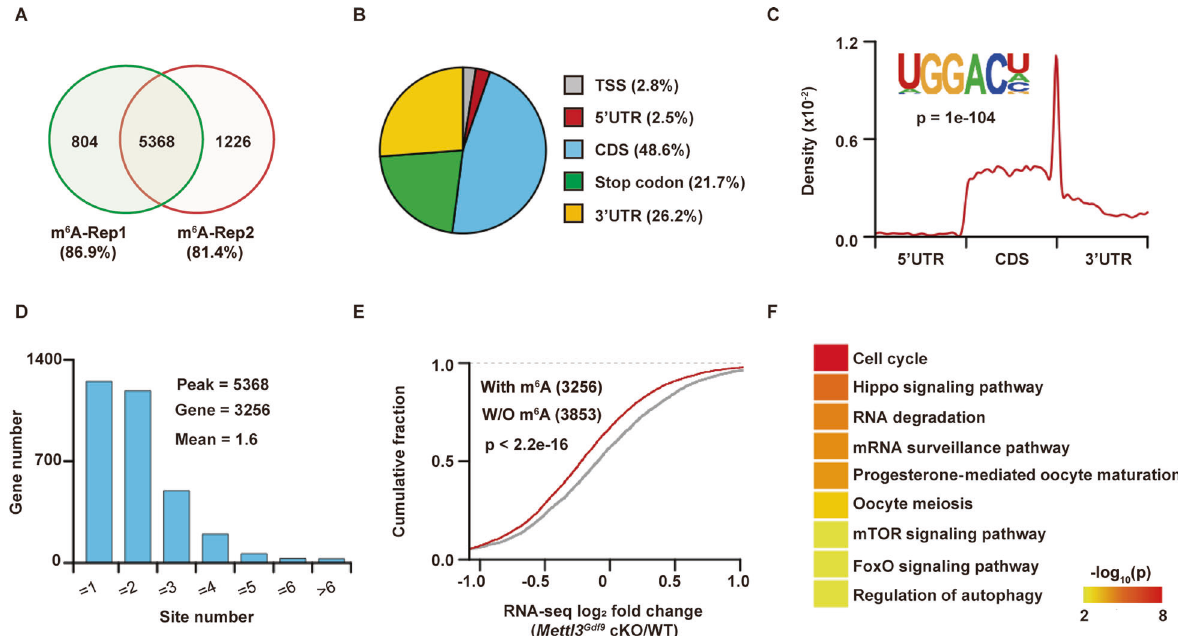
Fig. 4 Characteristics of METTL3-mediated m 6 A at the GV stage. A Venn diagram showing the overlay of m 6 A peaks in transcripts between two independent biological replicates. B Pie plot showing the percentages of m 6 A peaks on distinct mRNA segments: the TSS, 5 ′ untranslated region (5 ′ UTR), CDS, stop codon, and 3 ′ untranslated region (3 ′ UTR). C The m 6 A motif of GV oocytes enriched with HOMER (inner panel). The distribution pattern displays the position density of m 6 A across the 5 ′ UTR, CDS, and 3 ′ UTR of mRNAs (outer panel). D Bar plot showing the numbers of transcripts with different numbers of m 6 A peaks. E Cumulative distribution showing the differences (log 2 (fold change) values) in transcript expression between Mettl3 Gdf9 cKO and WT oocytes. The transcripts were classi fi ed as m 6 A and non-m 6 A by MeRIP-seq. The p value was determined with the two-sided Kolmogorov – Smirnov test. F Heatmap showing the signi fi cantly enriched KEGG pathways regulated by transcripts with m 6 A modi fi